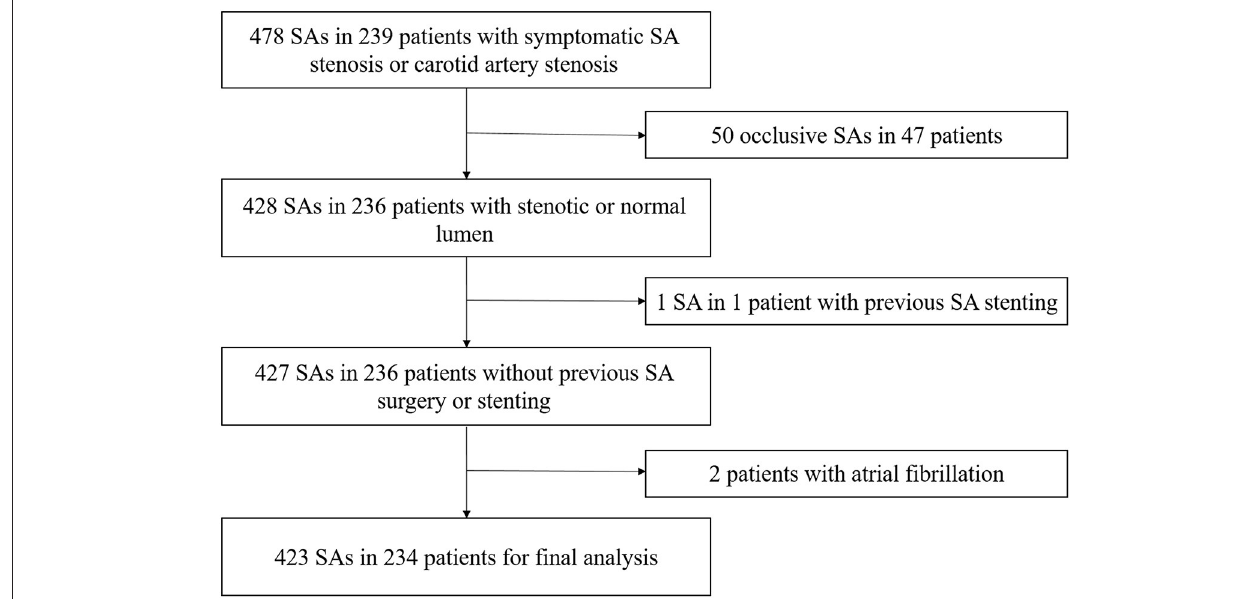
FIGURE 1 | Study inclusion/exclusion criteria. SA, subclavian artery.